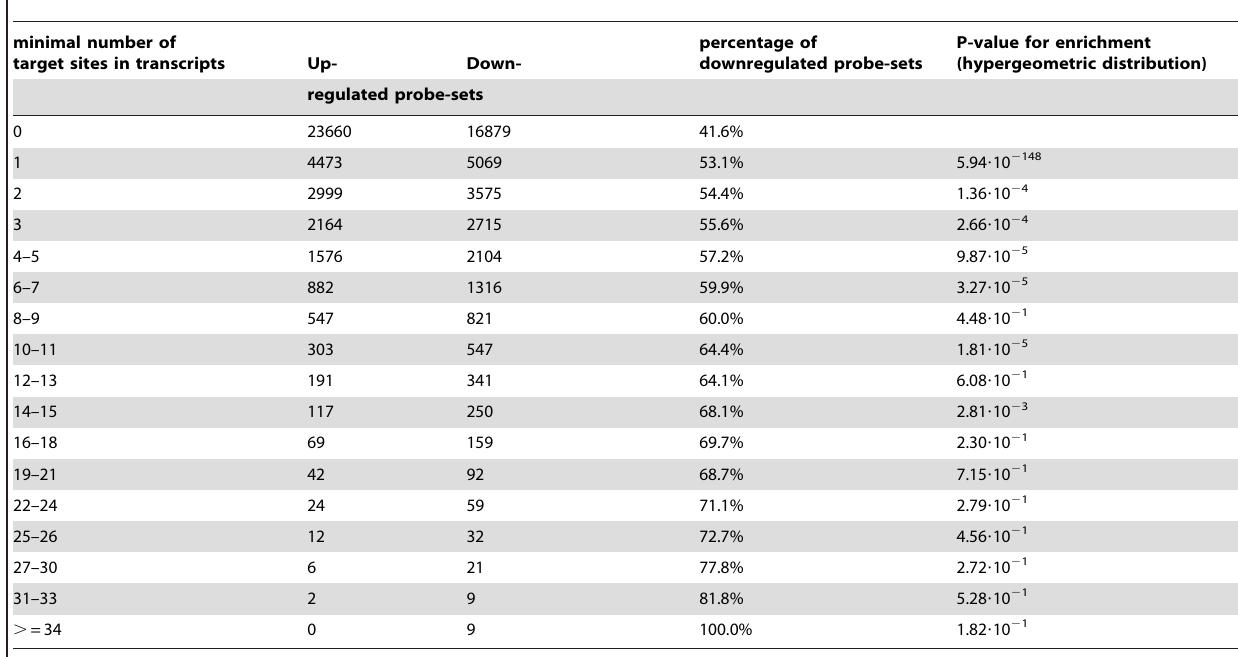
Table 1. Gene expression trends obtained for probe-sets that were mapped to the 77 miR-seeds that were found by t-test to display the most significant upregulation in breast cancer (FWER p ,